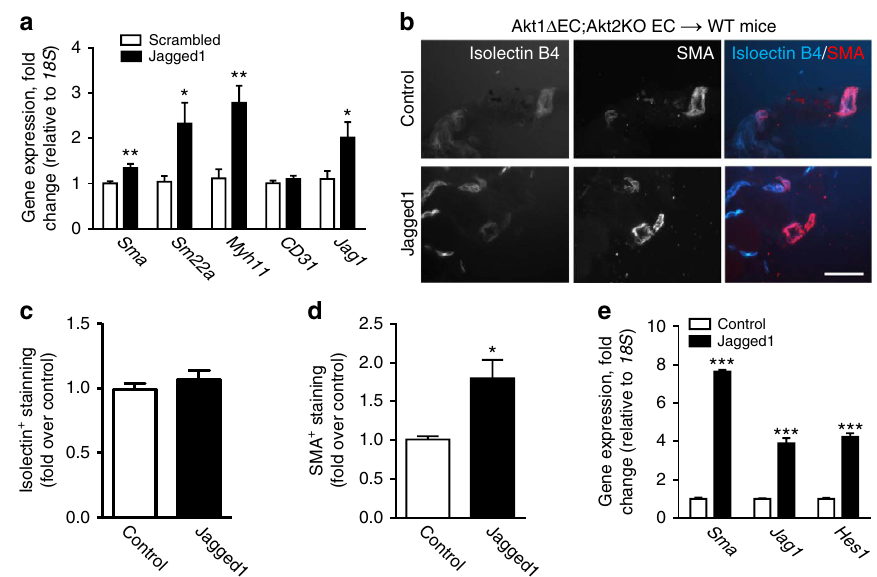
Figure 6 | Jagged1 overexpression stimulates VSMC coverage. ( a ) Gene expression normalized to 18S in Akt1 D EC;Akt2KO hearts from littermates treated either 25 m gg (cid:2) 1 scrambled or Jagged1 peptide for 1 week during 2 weeks of tamoxifen treatment represented as mean fold change from scrambled ± s.e.m. ( n ¼ 6). ( b ) Representative images of sectioned matrigels containing control or Jagged1 retrovirus-infected Akt1 D EC;Akt2KO ECs after injection into WTmice after 4 weeks tamoxifen treatment stained for isolectin B4 (blue) and SMA (red). Scale bar, 50 m m. ( c , d ) Quantification of isolectin B4 þ and SMA þ staining intensity represented as mean fold intensity over control ± s.e.m. ( n ¼ 5–7). ( e ) Gene expression normalized to 18S in matrigels containing control or Jagged1 retrovirus-infected Akt1 D EC;Akt2KO ECs after injection into WT mice as mean fold change form control ± s.e.m. ( n ¼